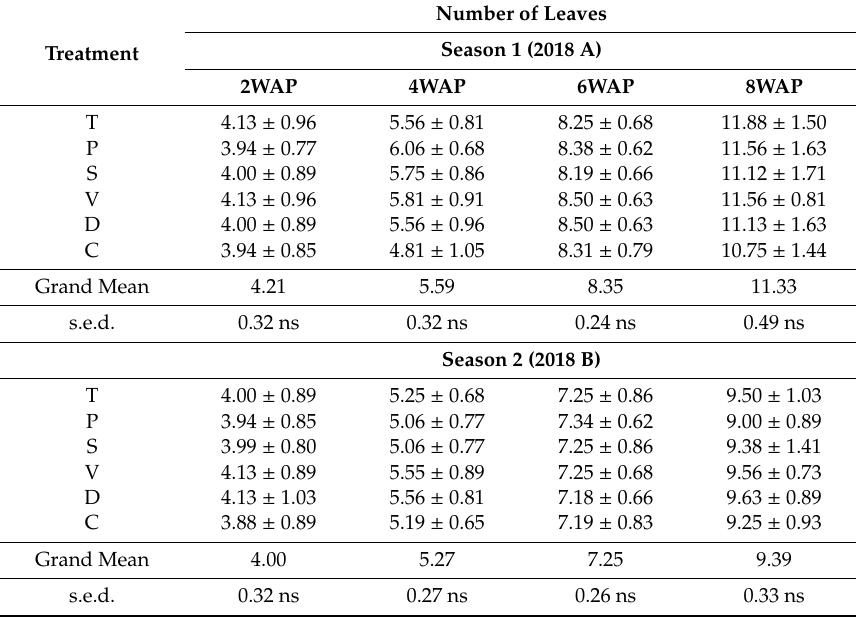
Table 3. Variation of the number of leaves in di ff erent treatments over two seasons.